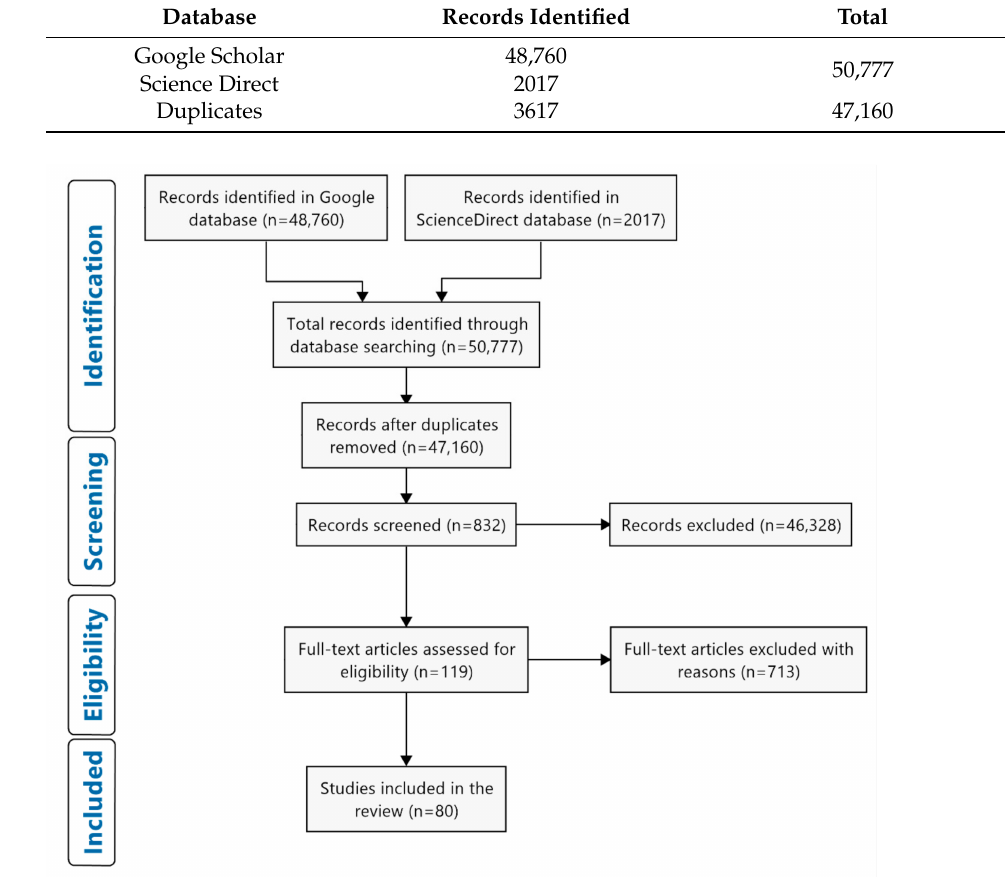
Figure 1. Search strategy and study